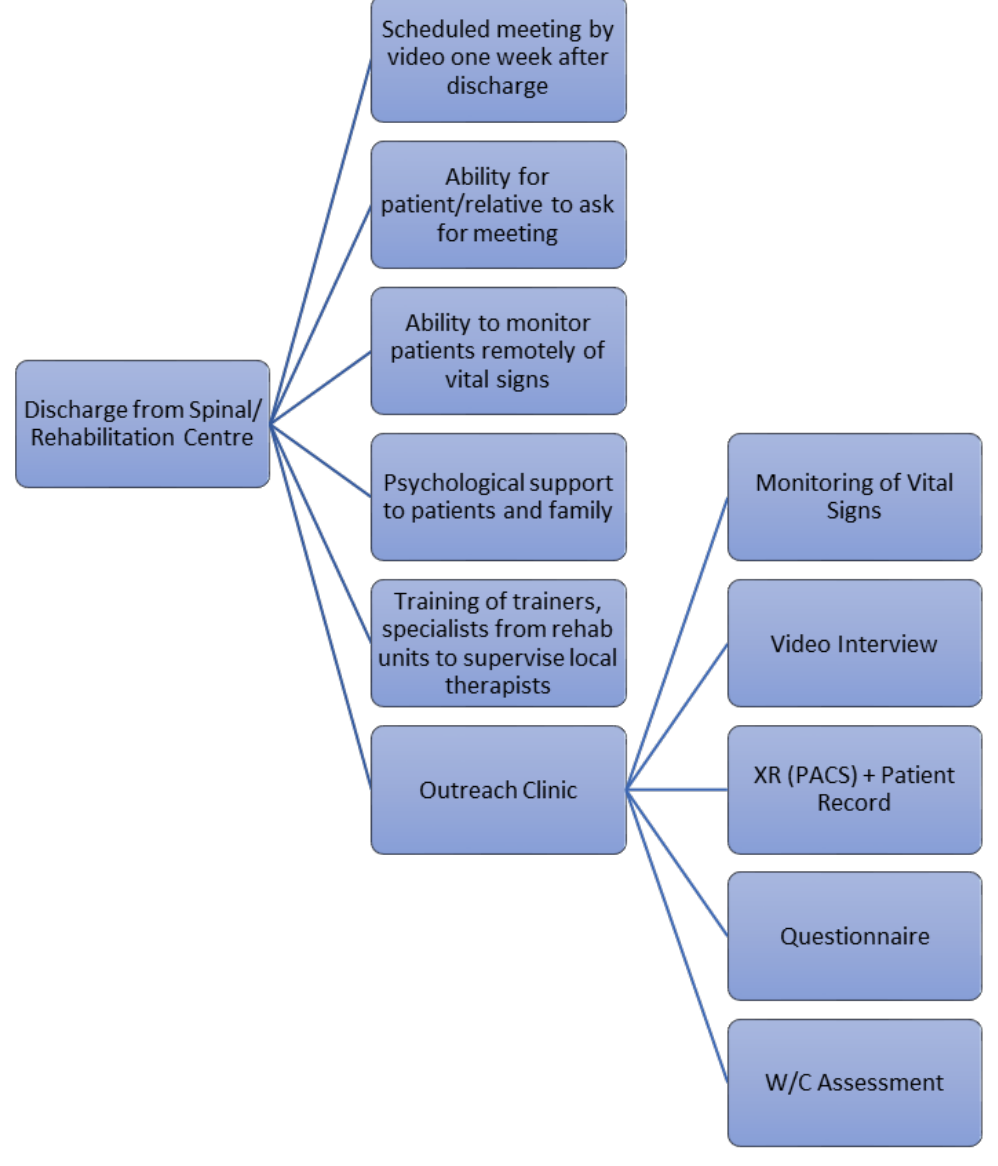
Figure 6. Use of technology at discharge into the